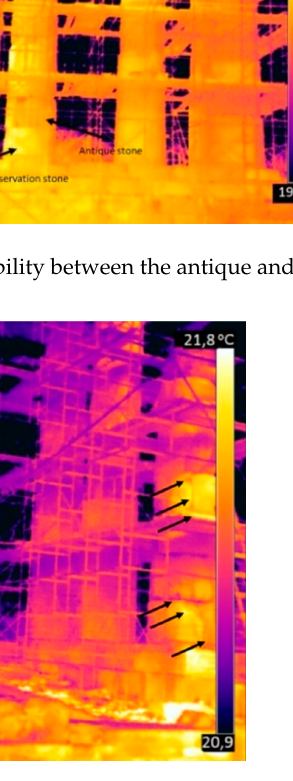
Figure 30. Cracks, cellulosic material and loss of materials are noted in the thermographic images as having lower temperatures.